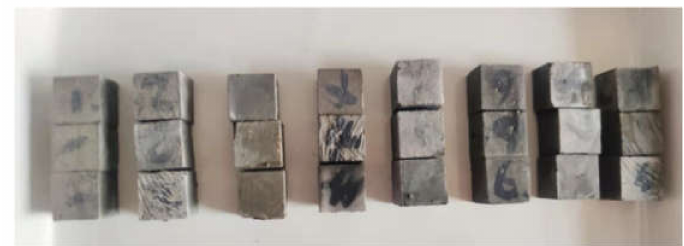
Figure 3. Cement slurry test block.